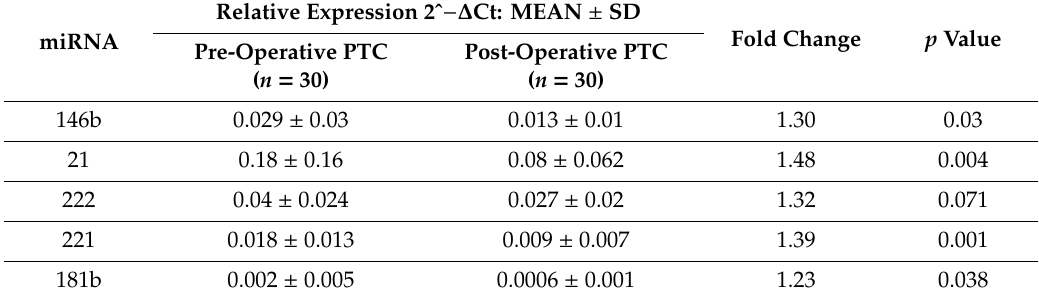
Table 2. Plasma miRNA expression in papillary thyroid cancer (PTC) patients before and after hemi thyroidectomy. Relative expression 2ˆ − ∆ Ct: MEAN ± SD miRNA Pre-Operative